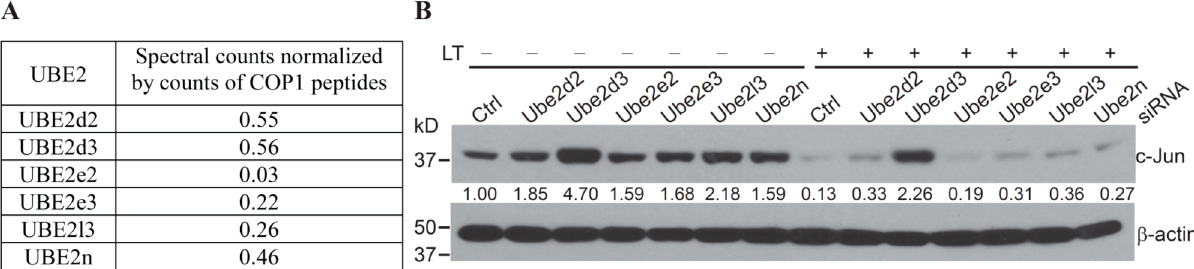
Figure 3. Ube2d2 functions as the E2 for COP1-mediated c-Jun degradation following anthrax lethal toxin (LT) treatment. ( A ) UBE2 in COP1 immunoprecipitated complex. Data shown are the relative spectral counts of UBE2s normalized by the spectral counts of COP1 peptides. ( B ) Hepa1c1c7 cells were transfected with the siRNA targeting the indicated Ube2s. Two days following transfection, the cells were cultured with or without LT for 2 h and then extracted with NuPAGE LDS sample buffer. Protein levels of c-Jun and β -actin in the cell lysates were assessed by Western blotting. Band intensities of c-Jun were quantified and normalized using β -actin levels. The normalized protein levels are shown under each band. Data shown are representative of three independent experiments.